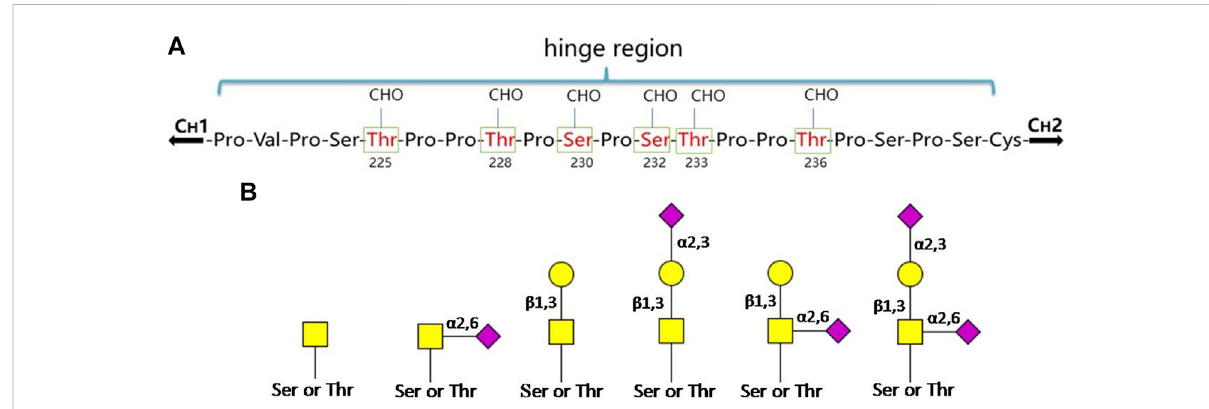
FIGURE 2 The O-glycosylation sites and glycan structures in human serum IgA1. (A) Boxed and numbered amino acids indicate the sites of attachment of O-linked glycans (CHO: carbohydrate) in the hinge region. (B) The core structures of O-glycans on human IgA1 are composed of GalNAc or GalNAc β -1,3-Gal. Both of them can be modi fi cated by Sia in different linkages ( : GalNAc; : Gal; : Sia) (Novak et al., 2000; Novak et al., 2018; Hansen et al.,